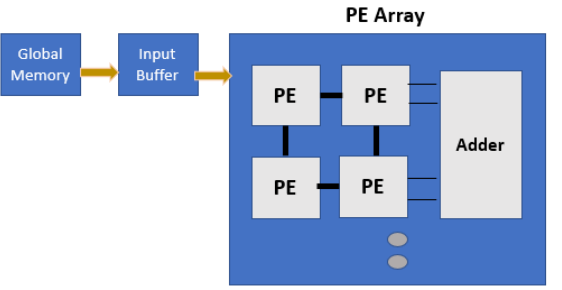
Figure 26. Block diagram depicting the RED architecture proposed in [28].